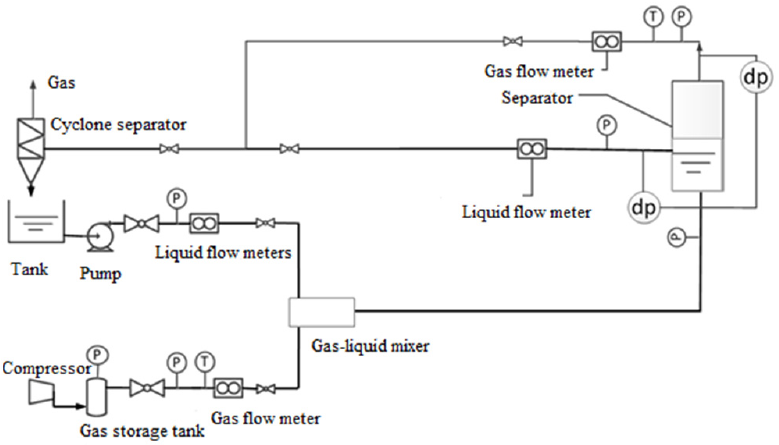
Figure 5. Separator experiment flow diagram.